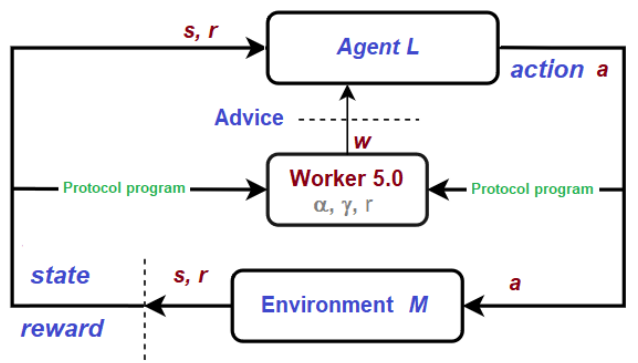
Figure 9. A general setup for RL with a human in the loop. Own elaboration, adapted from [119].